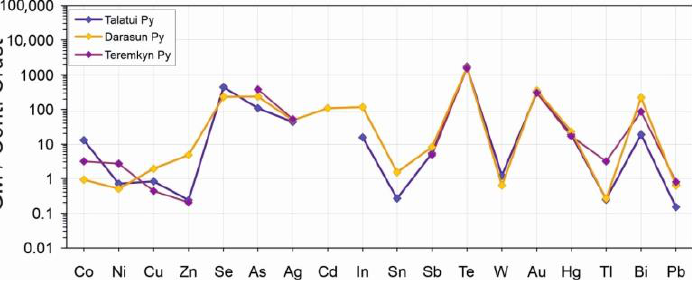
Figure 6. Multi-element diagram for pyrite (Py) from the Talatui, Teremkyn, and Darasun ores, normalized to the bulk continental crust [34]. GM—geometric means (Table 2) calculated from data presented in Table S2.